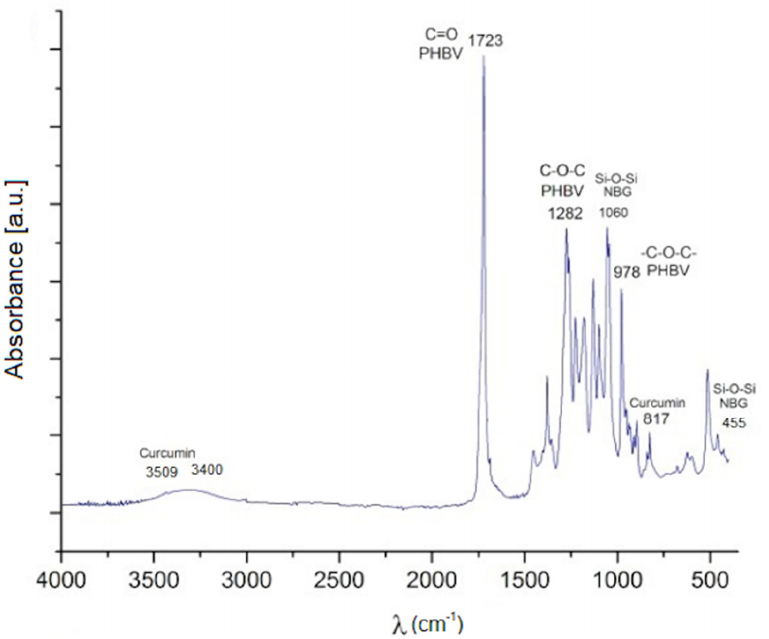
Figure 3. FTIR spectrum of a composite microsphere (70:30 PHBV/MBGN ratio). The detected peaks are discussed in the text.